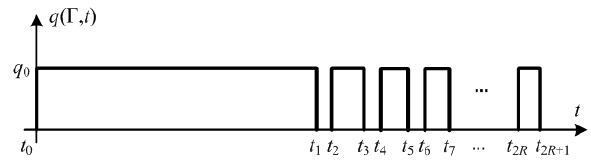
Figure 2: hange of the heat flux value during operation of the heater with a